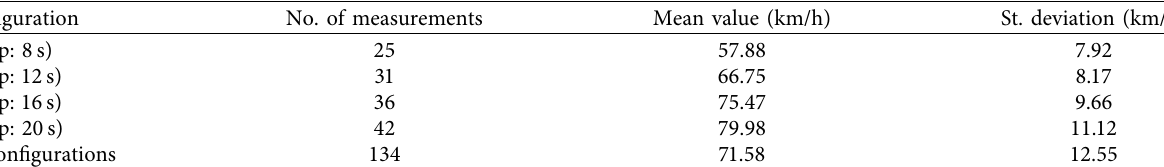
Table 4: Number of measurements, mean value, and standard deviation of speed in each analysis configuration.